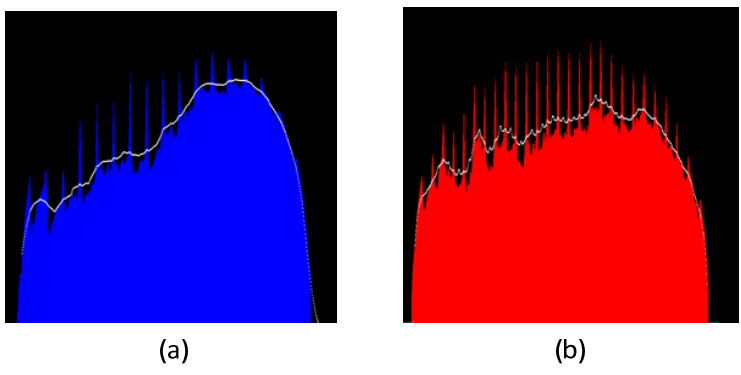
Figure 12. Result of the die sawing line detection.